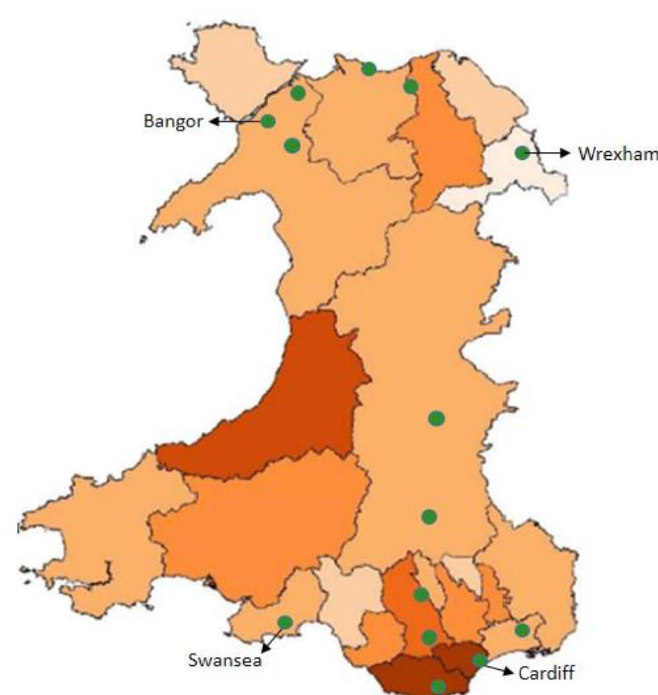
Figure 3: Map illustrating where Champion activity has taken place